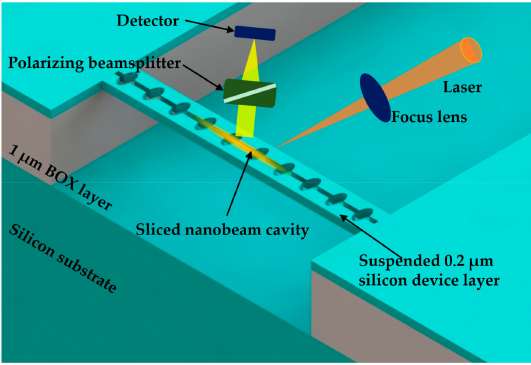
Figure 17. Sliced nanobeam optomechanical system with a free-space experimental setup.